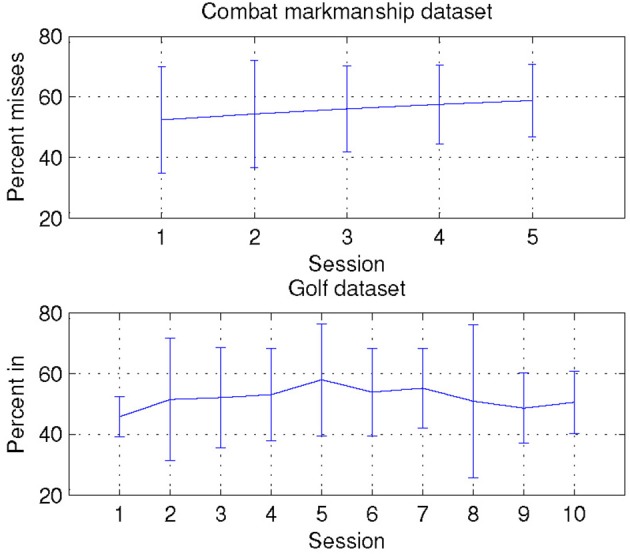
Averaged subject's performance for both combat marksmanship and golf dataset.